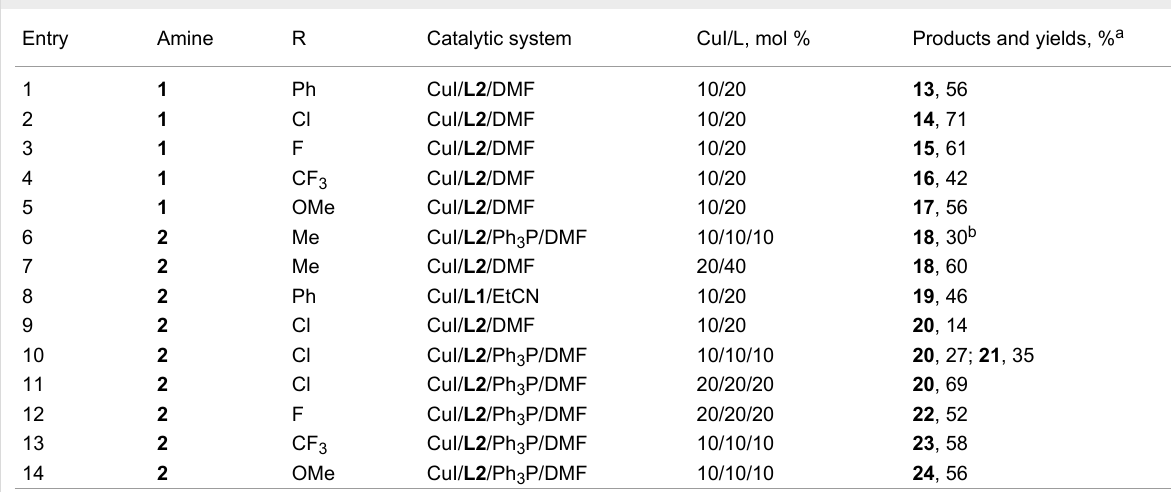
Table 2: Arylation of the diamines 1 and 2